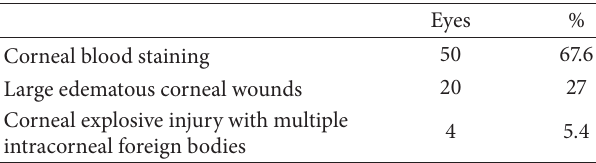
Table 2: Causes of corneal